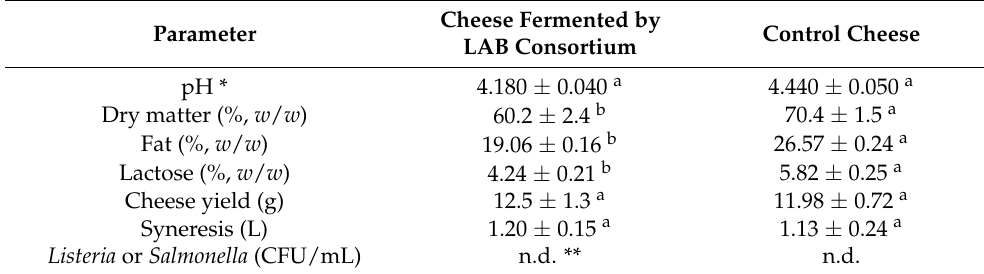
Table 2. Physicochemical properties of dried fresh cheese made by the LAB consortium compared to control cheese (fermented by starter culture DSM CT-203).